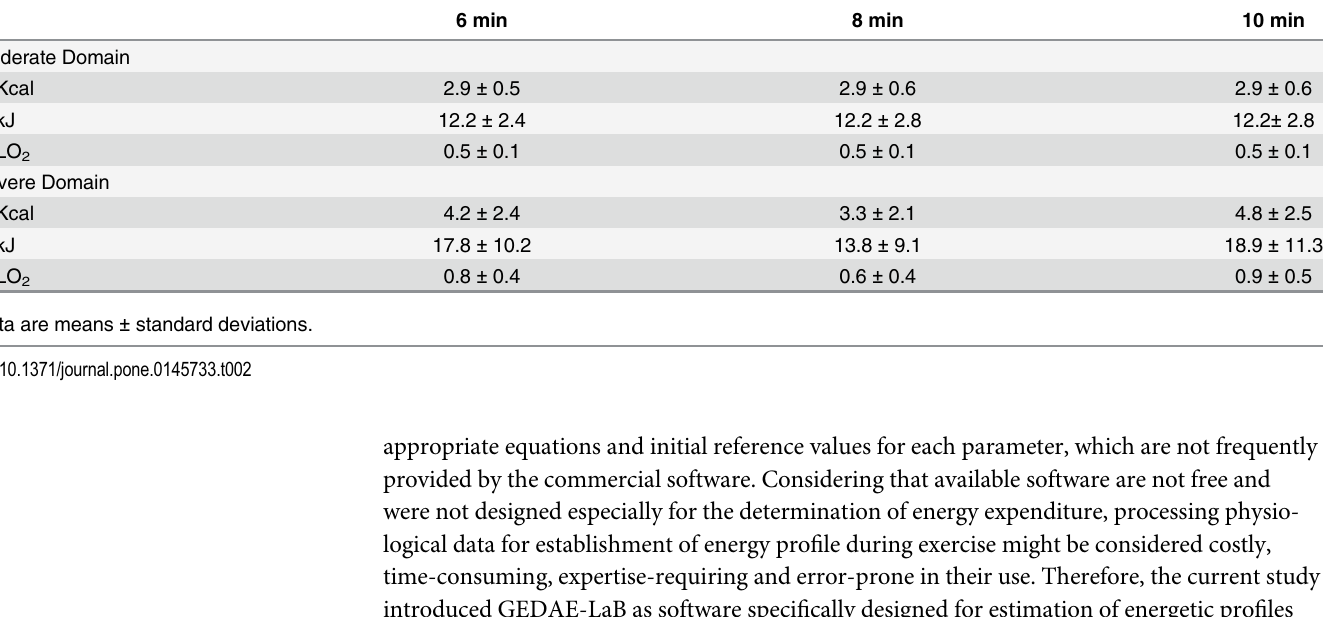
Table 2. Calculation of the anaerobic alactic system contribution during moderate and severe domains using different times of recovery.